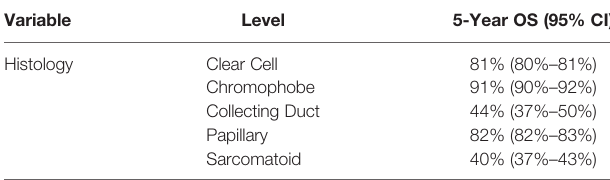
TABLE 2 | The 5-year OS of non-ccRCC compared to